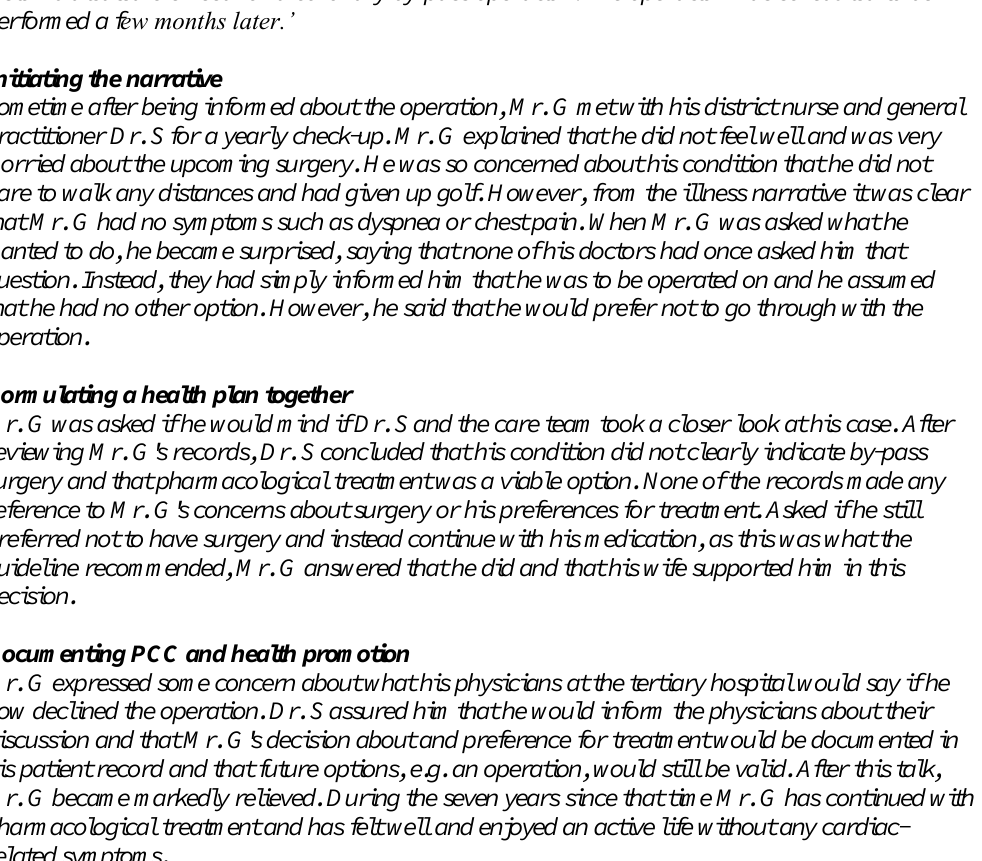
Figure 2. The illness story of Mr.